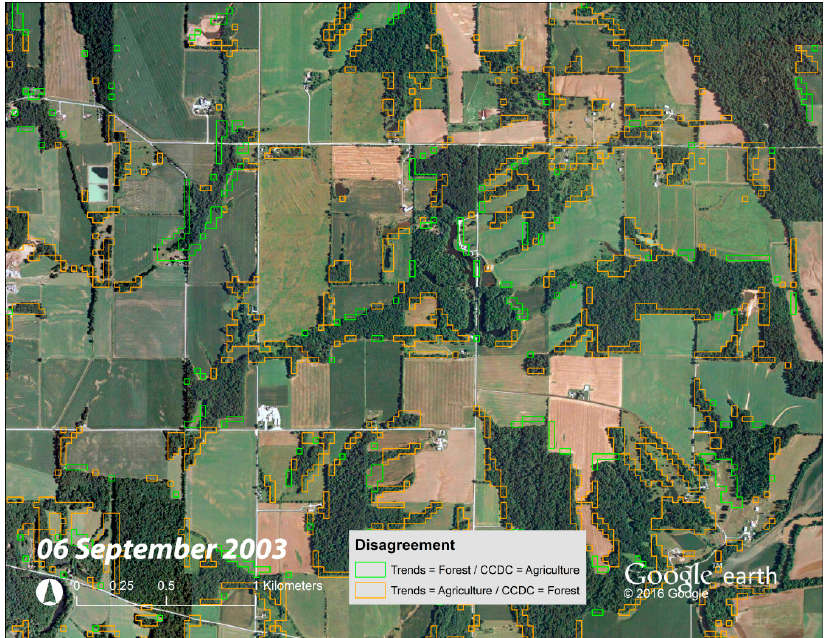
Figure 5. Example of the fragmented tree cover typical of LC Trends blocks in the Illinois/Indiana (22/33) study location (upper left corner: 39.40966°N. lat., − 87.04695°W. long.). Overlain vector layers identify locations of areas of Forest/Agriculture confusion, generally occurring at patch edges.